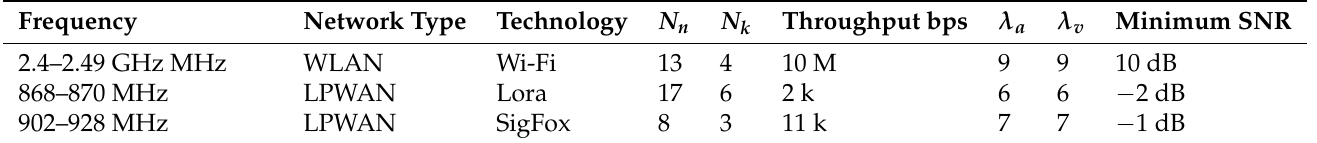
Table 2. Link parameter configurations.